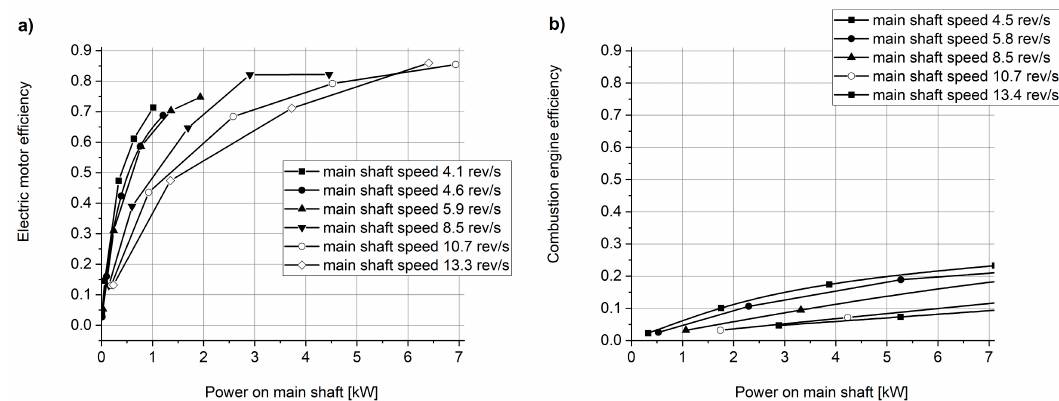
Figure 6. Efficiency of a ship propulsion as a function of the load and rotational speed of the main